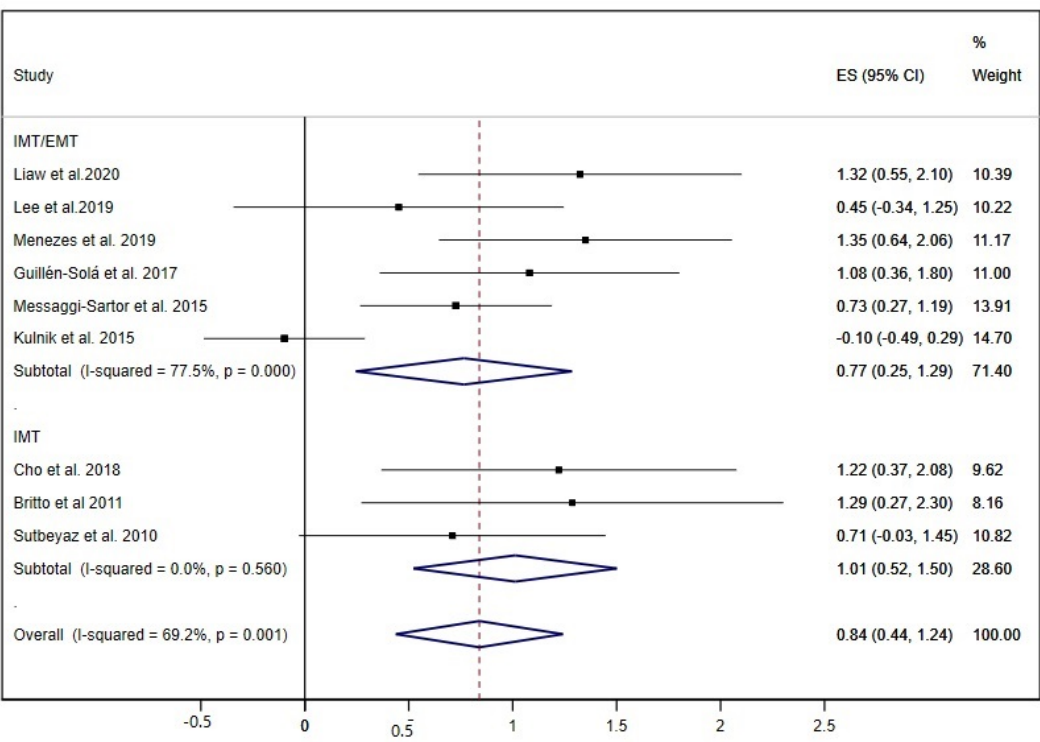
Figure 6. Forest plot showing the e ff ect size (ES) of respiratory muscle training (RMT) on maximal inspiratory pressure (MIP) between intervention and control groups for each study. IMT, inspiratory muscle training; EMT, expiratory muscle